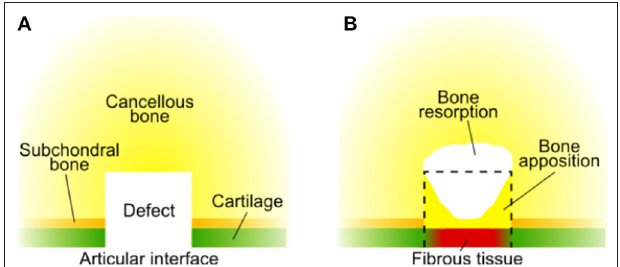
FIGURE 1 | Typical repair outcome of an untreated osteochondral defect summarizing the reports from literature. (A) Configuration of tissues at the time of defect generation; (B) repair outcome. The black dashed line marks the original size of the defect. Fibrous tissue has been reported to form at the articular interface (Furukawa et al., 1980; Shapiro et al., 1993; Schlichting et al., 2008). Bone apposition at the defect sides [until the interface with cartilage (Furukawa et al., 1980; Duda et al., 2005; Lydon et al., 2019)] and bone resorption at the defect base have been reported (Jackson et al., 2001; Duda et al., 2005). Bone resorption underneath the osteochondral defect might result in the formation of cysts (Jackson et al., 2001; Schlichting et al., 2008), whose composition may vary: fibrotic tissue, fatty scar tissue, or fluid ( Valderrabano et al., 2009). As numerous factors influence the repair outcome of osteochondral defects, significant differences might be observed in specific cases and this overview should be considered only as indicative.